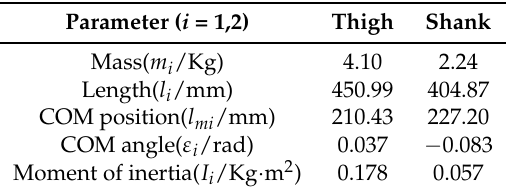
Table 1. Parameters of the thigh and shank